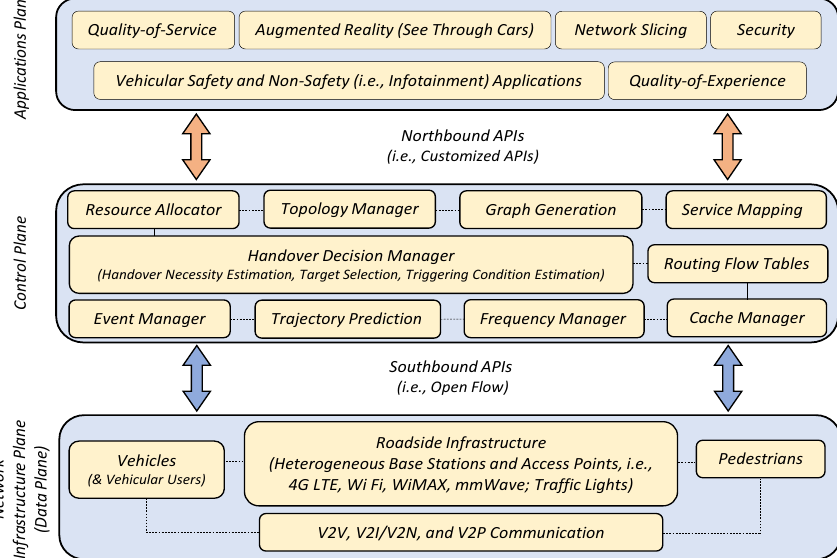
Figure 5. The logical architecture of